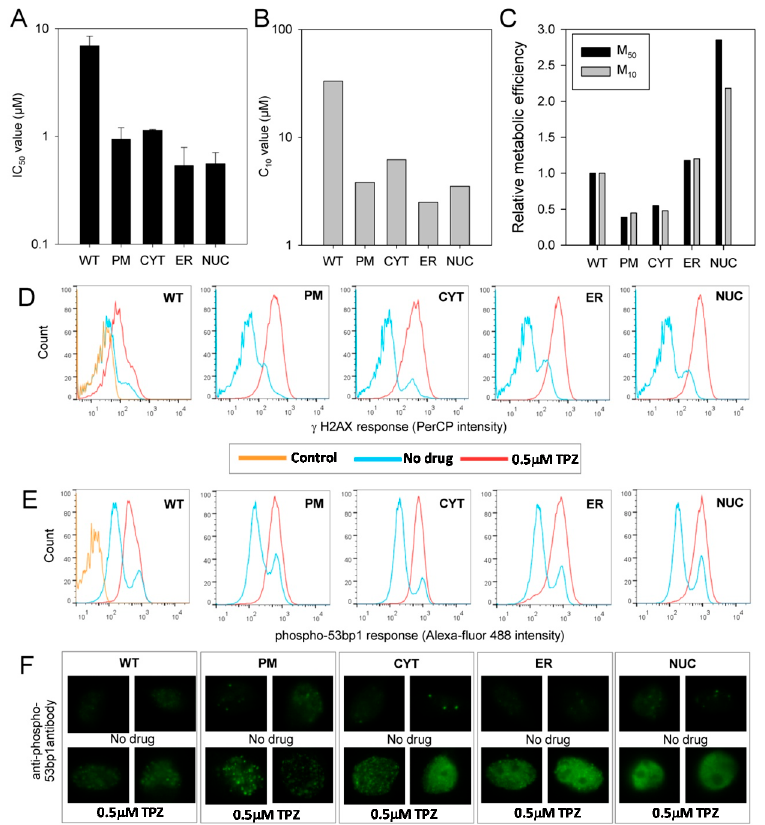
Figure 4. TPZ can achieve DNA damage under anoxia irrespective of the subcellular compartment of activation: ( A ) Sensitivity of parental and transfected MDA-231 cell lines to TPZ under anoxic conditions as determined by antiproliferative assay. IC 50 values show the mean of 2–3 independent experiments, error bars show the SEM; ( B ) Sensitivity of parental and transfected MDA-231 cell lines to TPZ under anoxic conditions as determined by clonogenic assay. The concentration of TPZ required to reduce clonogenic survival by 90% (C 10 values) were calculated in triplicate per drug concentration; ( C ) Relative metabolic e ffi ciency in MDA-231 transfectants (extent to which metabolism contributes to cytotoxicity). M 50 = 1 / (IC 50 × k met ) of anoxic TPZ metabolism as derived from Figure 2A. M 10 = 1 / (C 10 × k met ) of anoxic TPZ metabolism as derived from Figure 2A. The M 50 and M 10 values were normalized to the value for MDA-231 WT cells; ( D ) Flow cytometry analysis of γ -H2AX levels in parental and transfected MDA-231 cells following a 4 h anoxic exposure to 0.5 µ M TPZ and a 1 h drug-free recovery period under aerobic conditions. Control: no antibody labelling; ( E ) Flow cytometry analysis of phospho-53bp1 levels in parental and transfected MDA-231 cells following a 4 h anoxic exposure to 0.5 µ M TPZ and a 1 h drug-free recovery period under aerobic conditions. Control: secondary antibody only; ( F ) Immunofluoresence microscopy showing phospho-53bp1 foci formation following a four-hour anoxic exposure to 0.5 µ M TPZ and a 1 h drug-free recovery period under aerobic